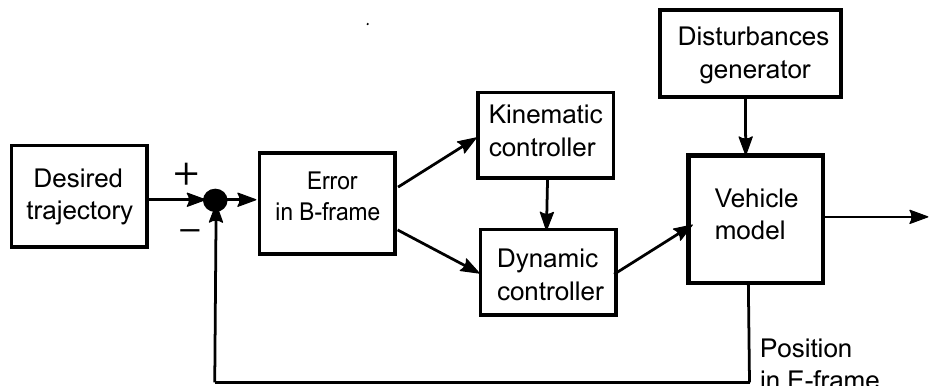
Figure 2. Proposed control